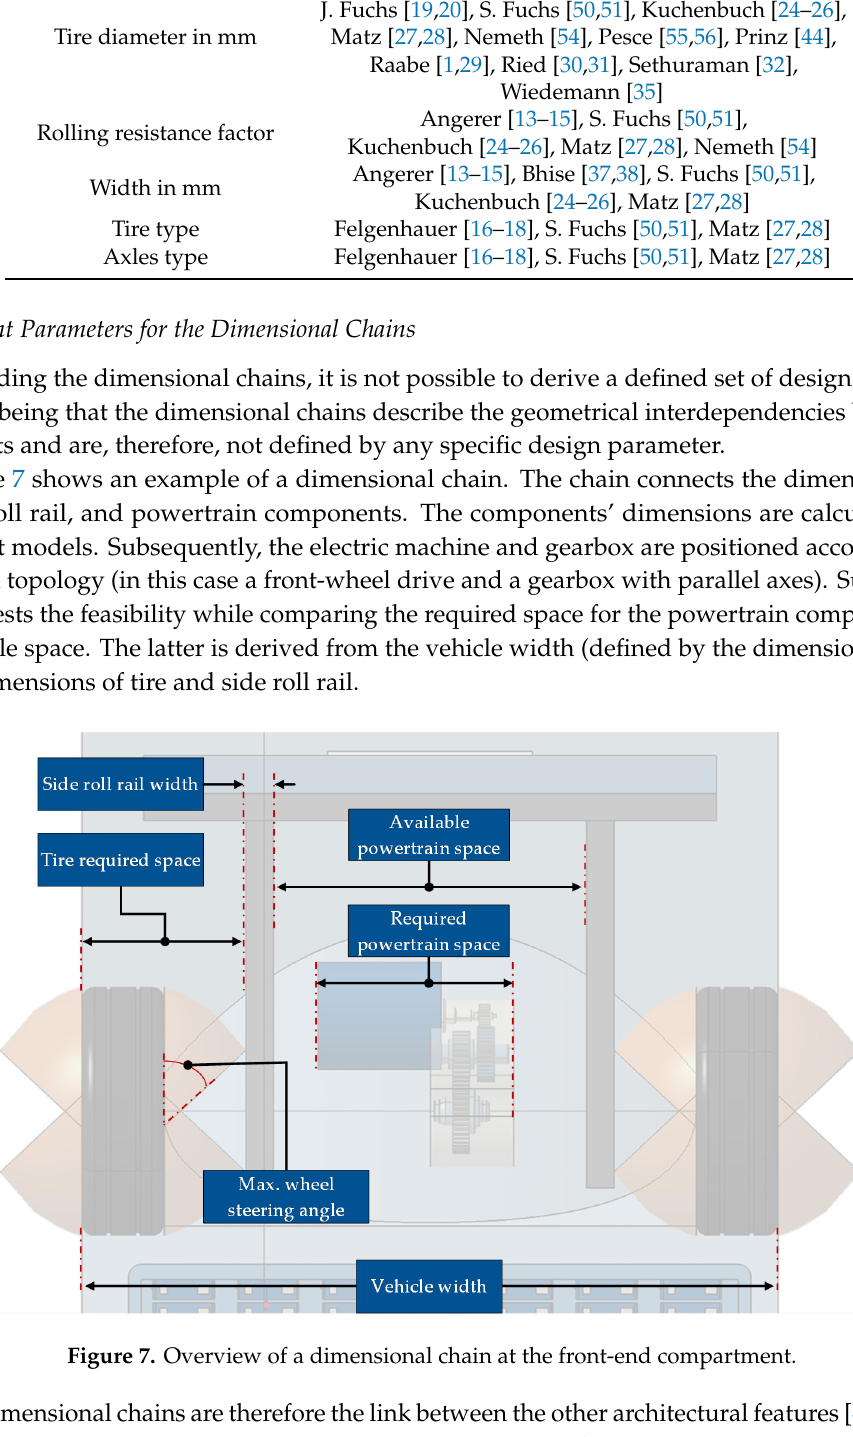
Table 7. Overview of the design parameters for the tires and axles.